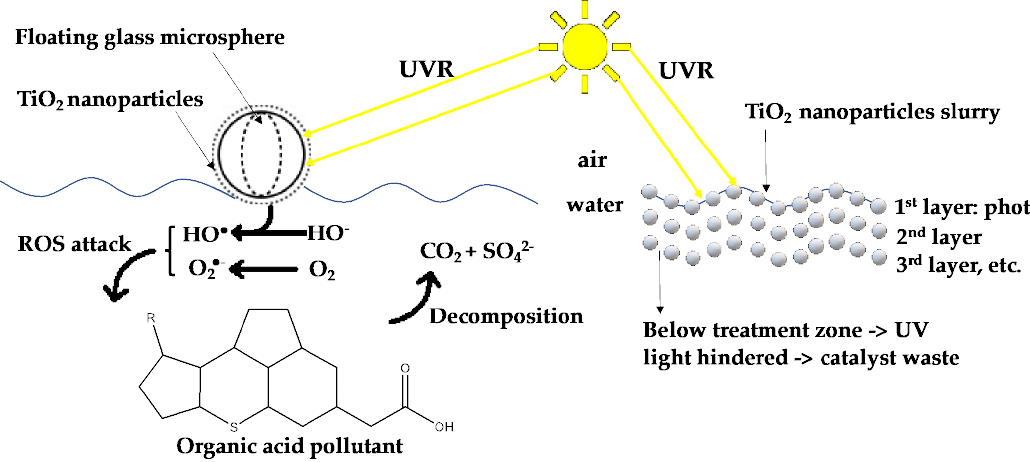
Figure 4. Floating photocatalystat the air–water interface vs. conventional titania slurry. UVR = ultraviolet radiation. ROS = reactive oxygen species. HO = hydroxyl, O 2 = oxygen, CO 2 = carbon dioxide. SO 42 − = sulphate. Adapted from ref.